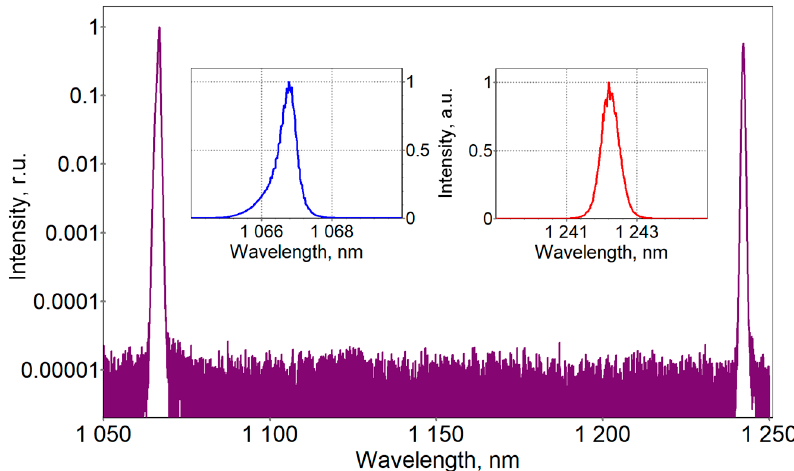
Figure 6. Measured optical spectrum of the dual-wavelength pulsed laser radiation obtained upon a quasi-synchronous pumping with the modulation frequency of 208.8 kHz (resolution: 0.1 nm). The spectrum was acquired via the WDM following the P 2 O 5 -doped fiber. Insets represent zooming in the vicinities of the fundamental ( left ) and Stokes ( right ) wavelengths.